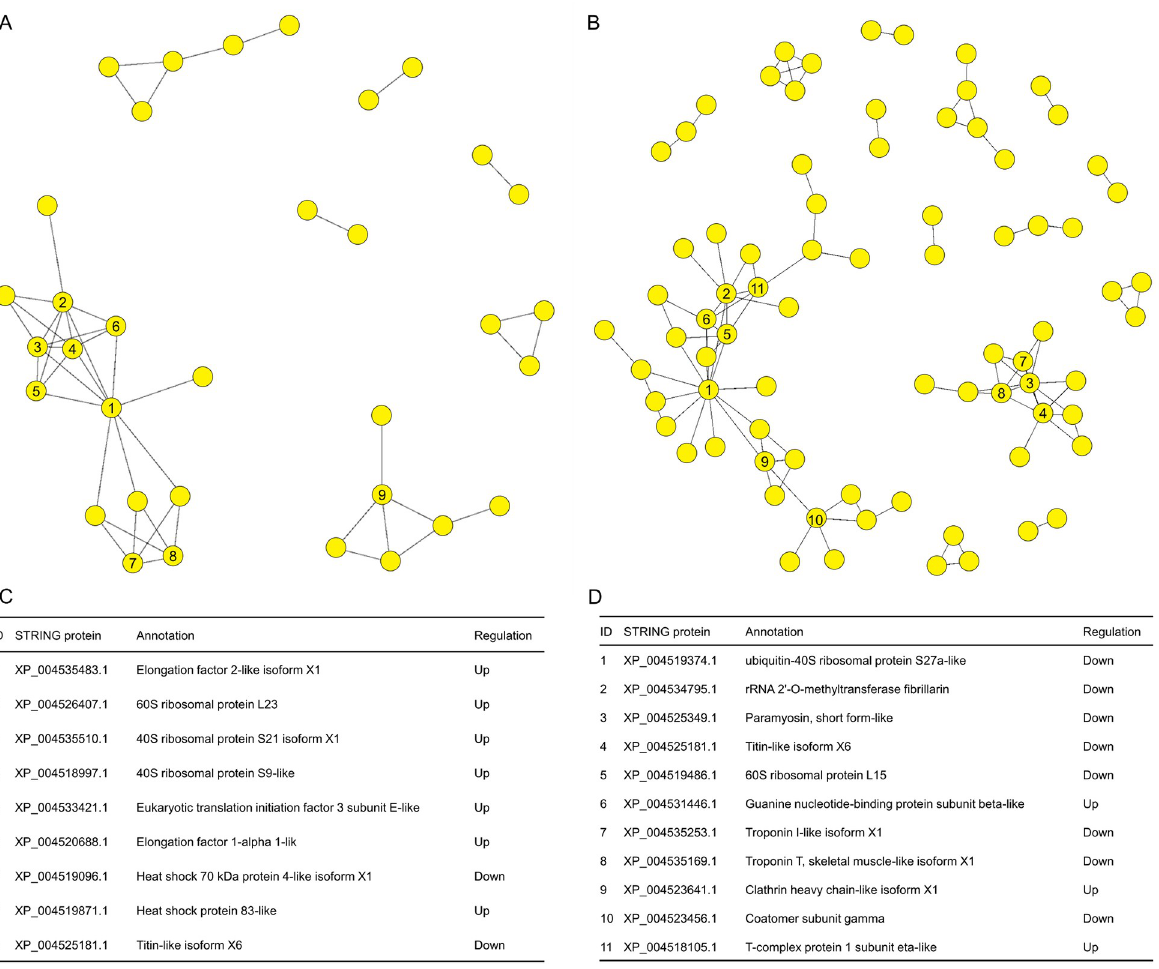
Fig 7. Protein-protein interaction (PPI) information of differentially abundant proteins (DAPs) between non-diapause-(ND) and diapause- destined (D) pupae of Bactrocera minax . (A and C) PPI information in ND1 vs D1 comparison. (B and D) PPI information in ND15 vs D15 comparison. (A and B) PPI networks. (C and D) Information of DAPs connected with at least four nodes in each PPI network.